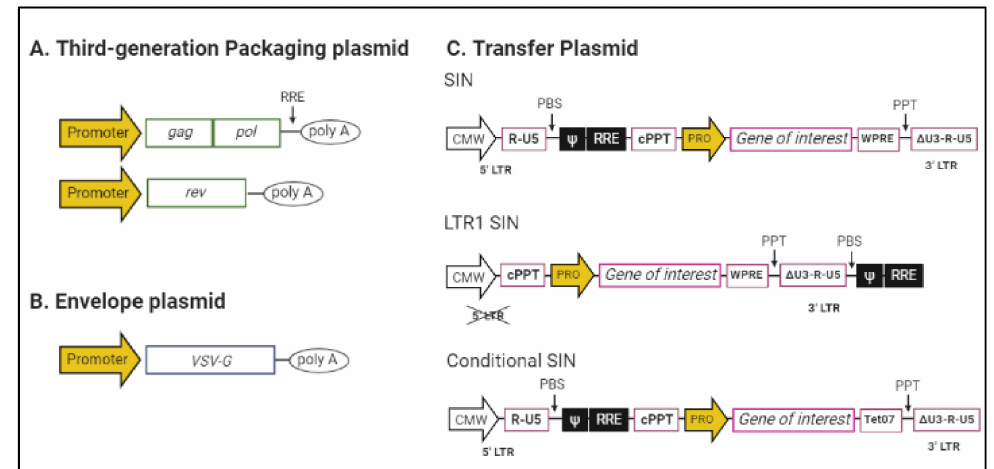
Figure 1. Plasmid designs for lentiviral vector (LV) production. ( A ) Third-generation LV has two